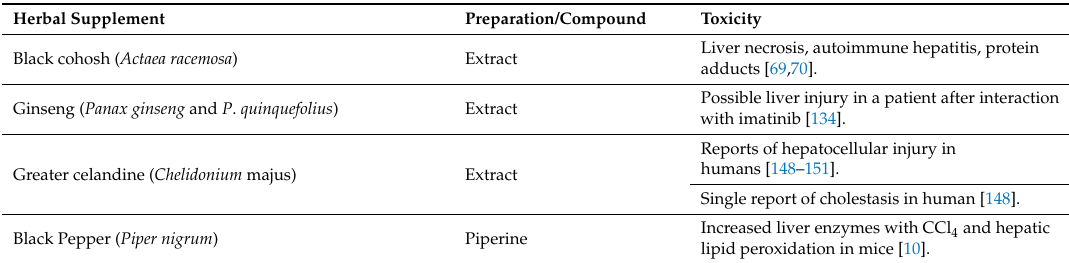
Table 3. Reported Hepatotoxicity of Herbal